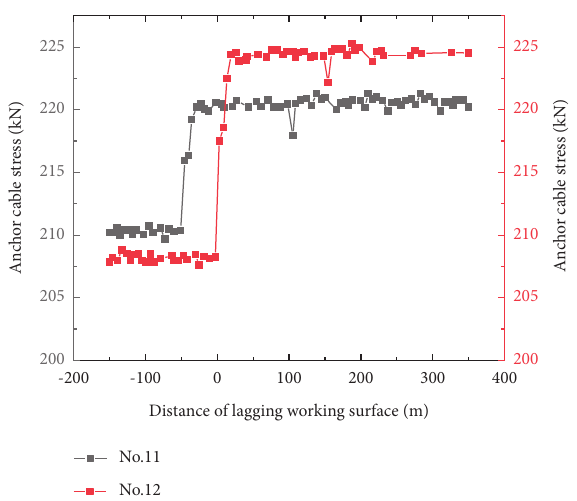
Figure 7: Variation curve of anchor cable stress obtained using a stress meter. Table 4: Key positions and maximum tensile stress of the anchor cable stress change curve. Anchor cable stress